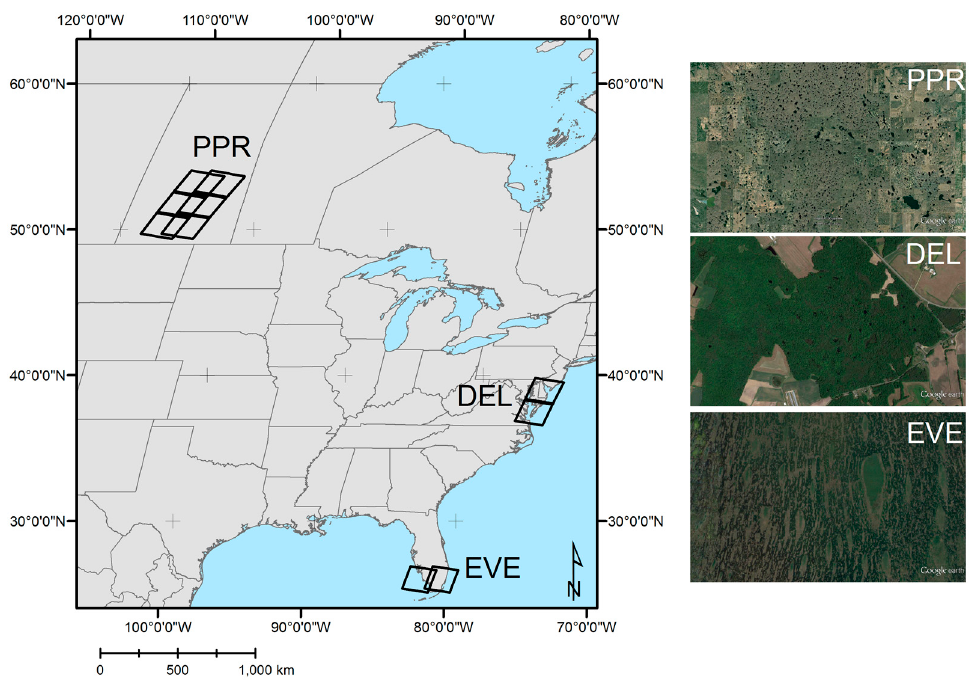
Figure 1. Location of the three study sites—the Prairie Pothole Region (PPR), Delmarva Peninsula (DEL) and the Everglades (EVE)—with Landsat path/row (solid borders). Google Earth imagery (right) are shown for each site to demonstrate the wetland types included in this study (PPR: small hemispherical wetlands; DEL: forested depressional wetlands; EVE: large heterogeneously inundated wetlands).